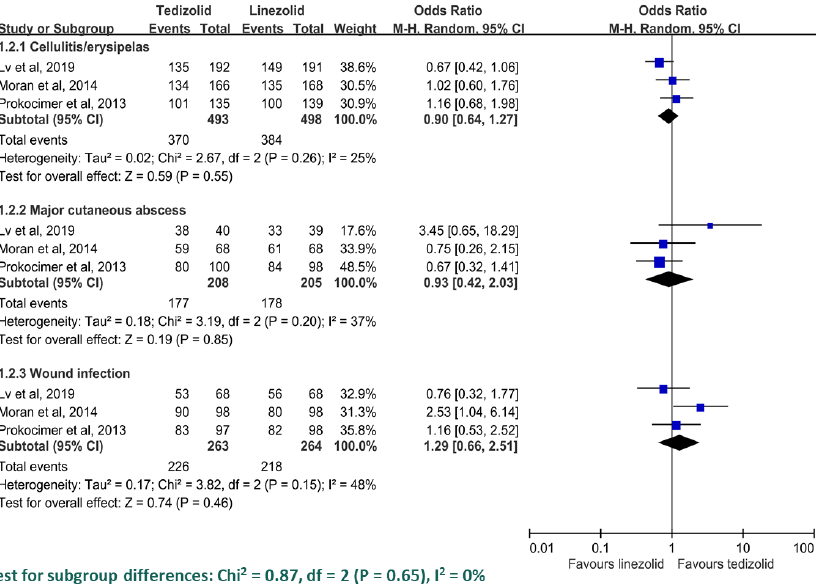
Figure 3. The clinical response between tedizolid and linezolid.